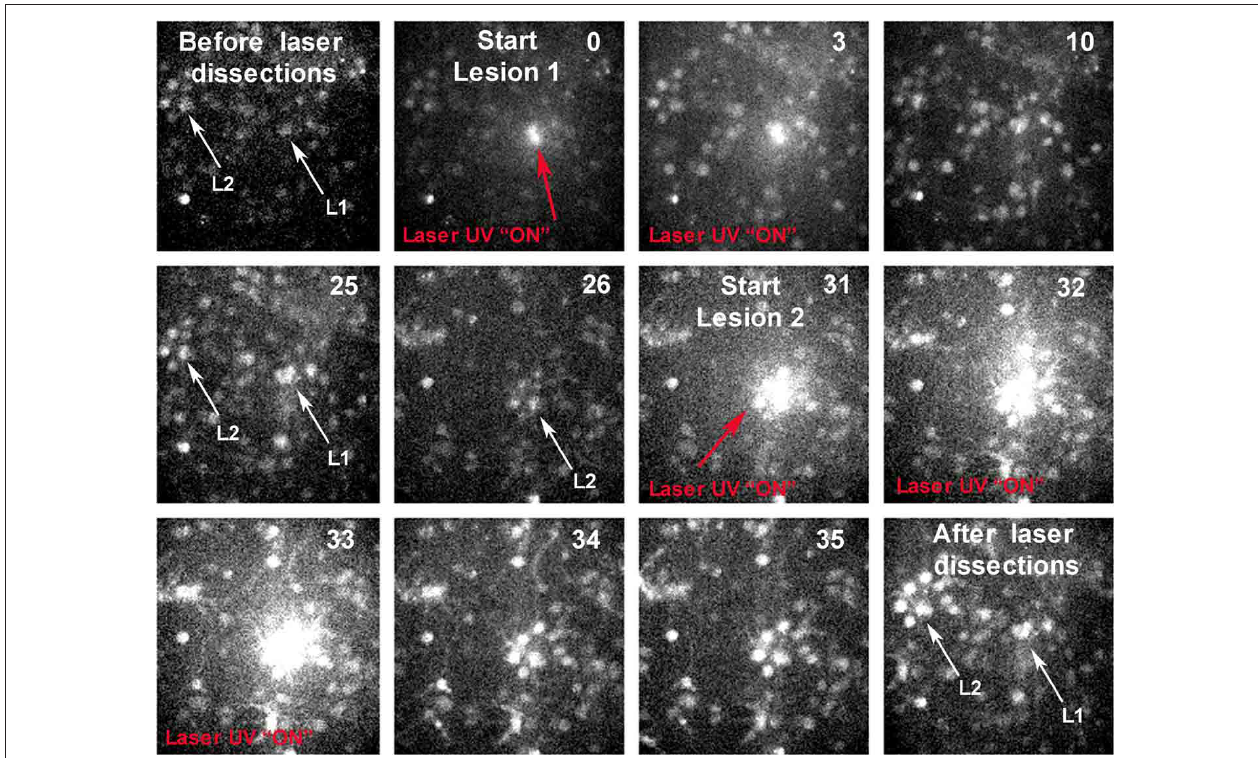
2, is 5 μ W. We delivered 300 UV light pulse for each lesion, at pulse-repetition rate of 100Hz. At 25s, after Lesion 1, the L2 position is centered onto the UV focus spot. The last panel shows the same field of view of the first one, after laser inflicted damages. The cells directly affected by the UV laser presented saturated calcium signal. Numbers indicate seconds. The field of view is 150 × 150 μ m. Calcium imaging was acquired at